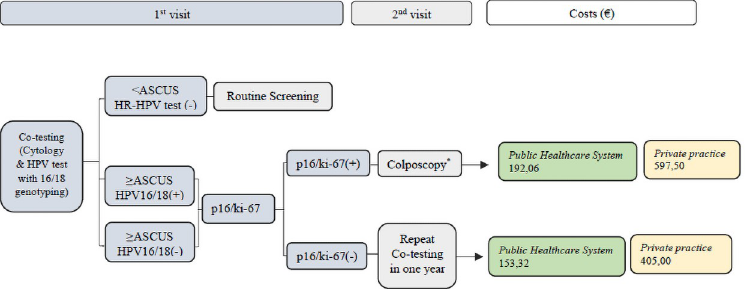
Fig 4. Third strategy: Co-testing as primary screening. Triage with p16/ki-67 dual stain. Cytology, LBC; Costs in Euros ( € ), direct medical costs (screening tests, colposcopy with biopsy and office visit) per woman screened; costs for annual follow-ups and treatments for CIN were not included. � Colposcopy with